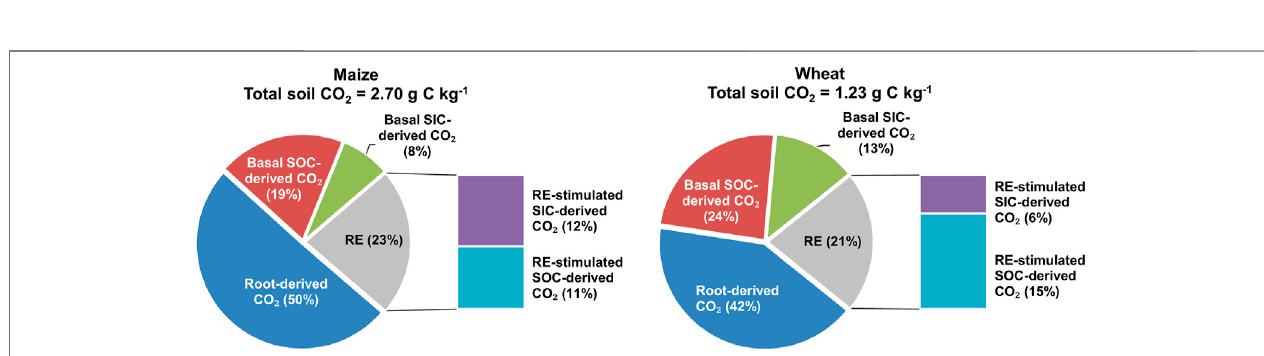
FIGURE 6 | Contribution of five C sources (basal SOC- or SIC-derived CO 2 , root-derived CO 2 , and RE-stimulated SOC- or SIC-derived CO 2 ) to cumulative CO 2 emissions from the belowground system over the whole growth stage. Note: RE stands for the rhizosphere effect.